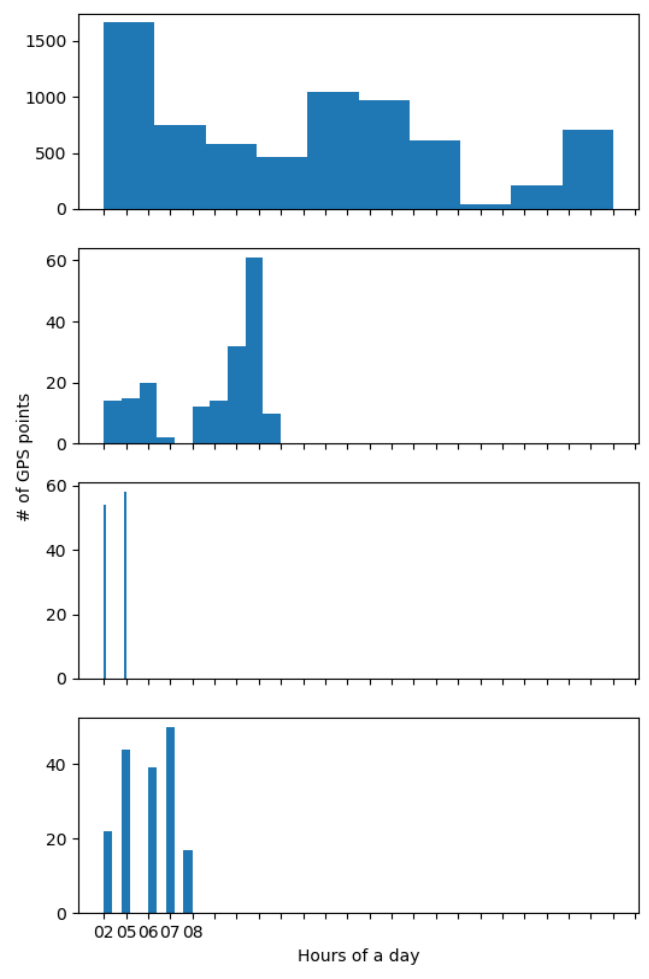
Figure 2. The illustration of user trajectory clustering.